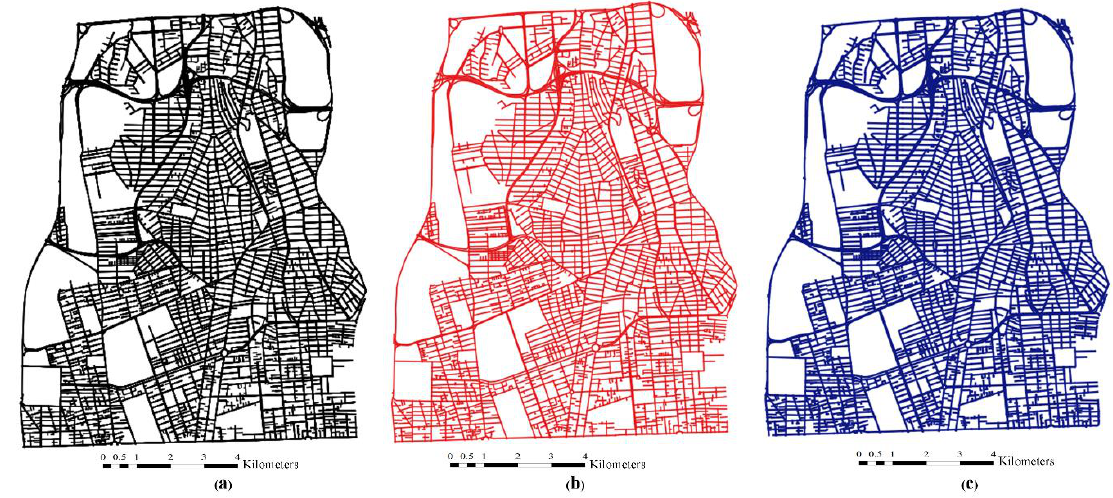
Figure 12. Study area: ( a ) the OSM data history file; ( b ) the latest version of the OSM; and ( c ) the reference dataset.